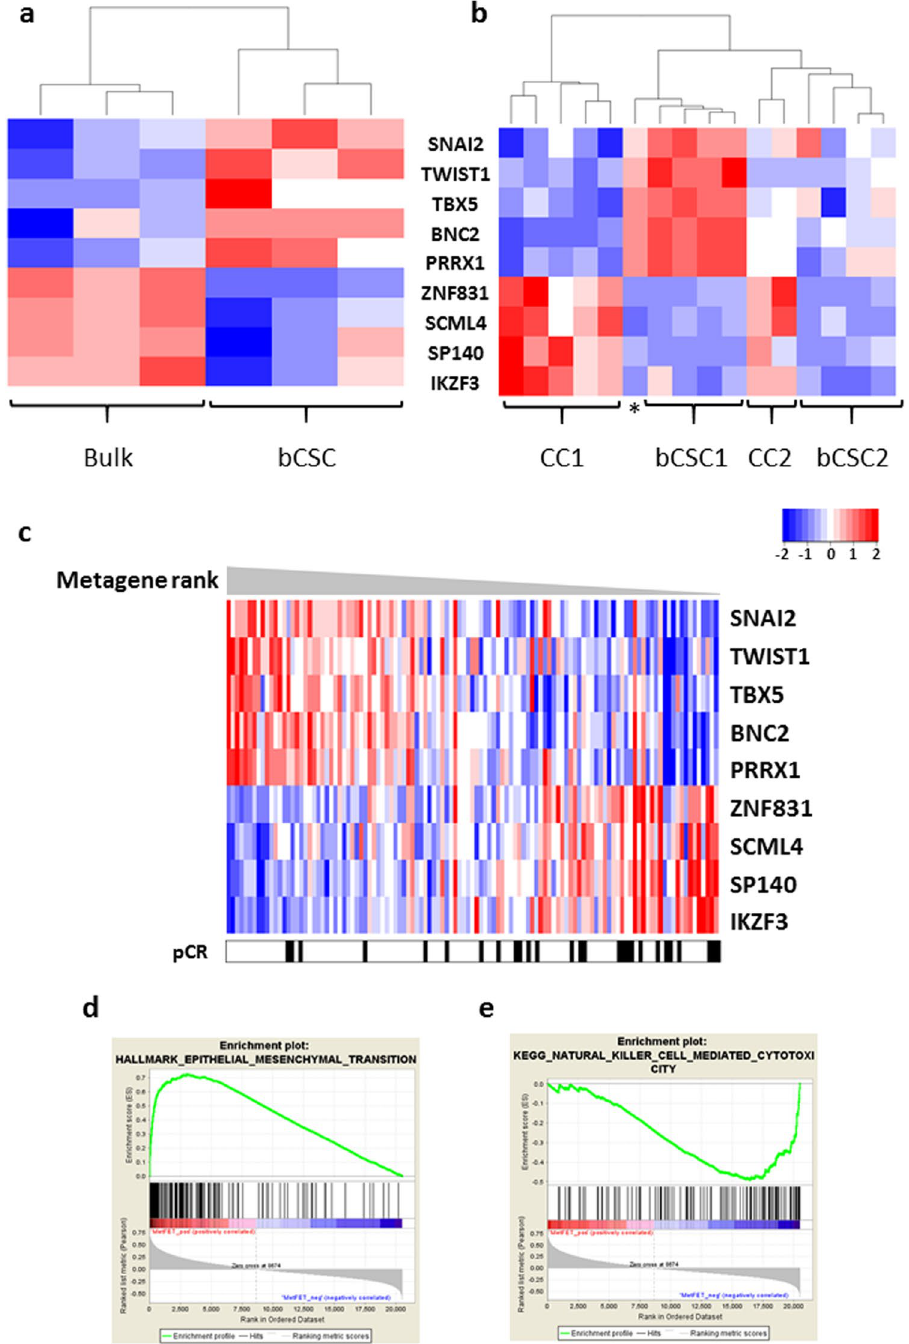
Figure 2. Transcription factor networks derived from breast cancer stem cells and its role in tumour tissues. Hierarchical clustering based in the expression of the TFs of the two modules: ( a ) - “bCSC/Bulk” dataset, ( b ) - “bCSC/CC” dataset, * refer to Biological Replicate 1 CC. ( c ) – NACT dataset showed an inverse coordinated expression of the TFs from the two networks and dataset are correlated to the complete disappearance of the tumour under treatment. When divided into two groups (58 vs 57 samples), there is a ratio of 3.57 of pCR in the group expressing less cancer stem cell TFs, p = 0.0008. “d” and “e” - GSEA datasets positively (“F), and negatively (“G”) correlated with high expression of the bCSC metagene composed of the 9 TFs in NACT dataset. ( d ) – Hallmark of Epithelial to Mesenchymal transition, ( e ) – KEEG Natural Killer Cell Mediated Cytotoxicity, evaluated by GSEA in a continuous way using Pearson metrics to rank the genes. p ≤ 0.05, FDR ≤ 0.01. bCSC = breast cancer stem cell, CC = cancer cell, pCR = Pathological Complete Response to Chemotherapy. Metagene Rank: Order of the samples as calculated by the expression of the